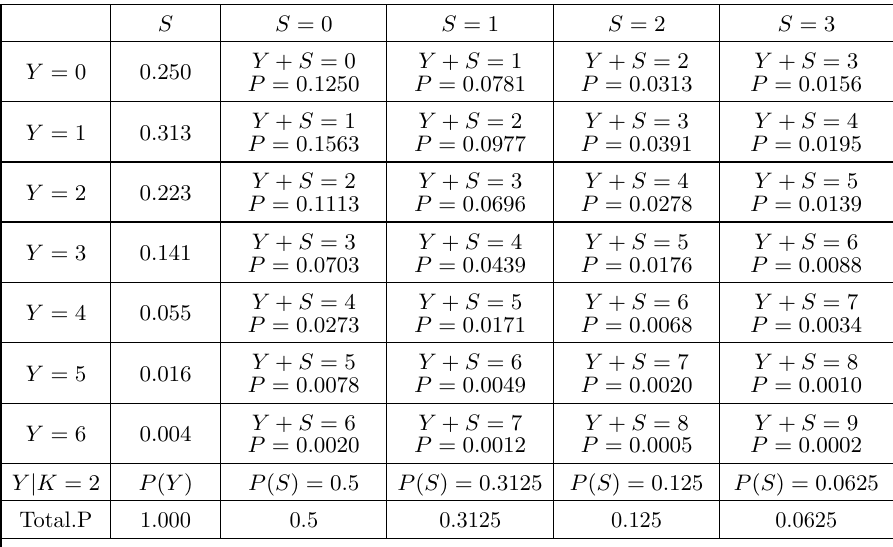
Table 1. Computing distribution { P ( Y 3 ) } on the base of the known distribution { P ( Y 2 ) }